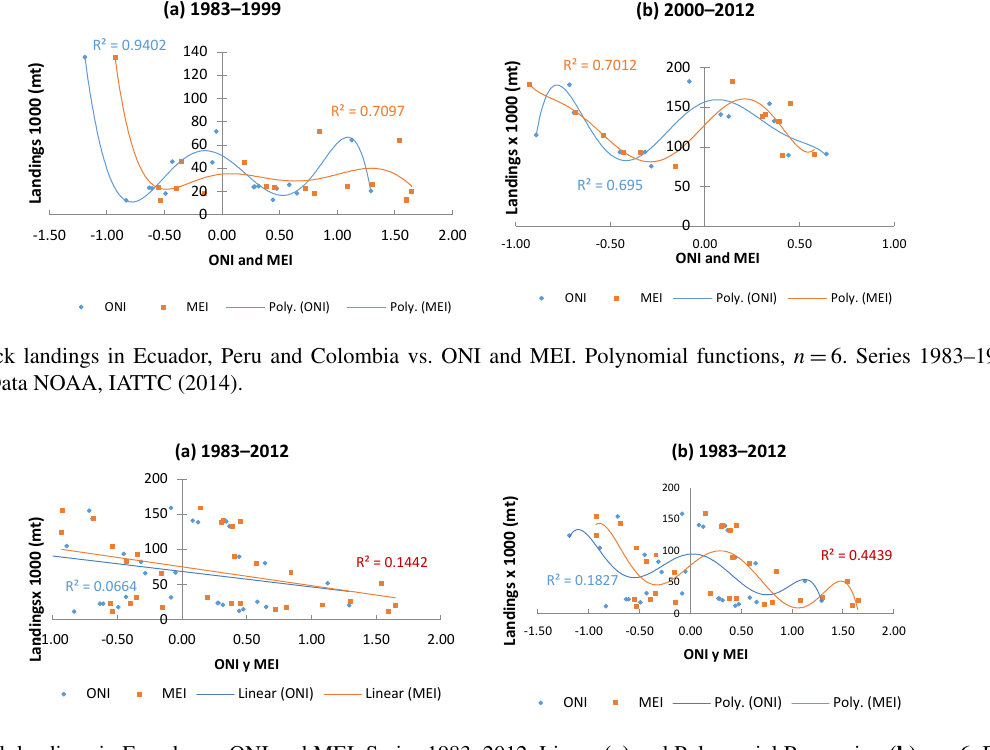
Figure 6. Skipjack landings in Ecuador vs ONI and MEI. Series 1983–2012. Linear (a) and Polynomial Regression (b) n = 6. Data NOAA and IATTC (2104).